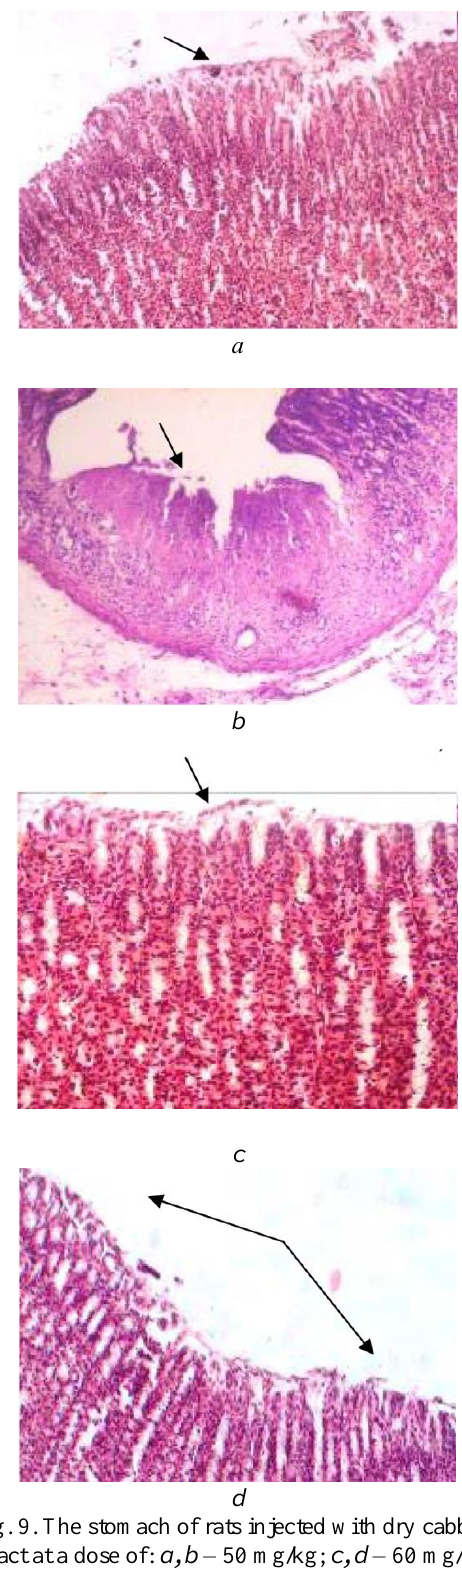
Fig. 9. The stomach of rats injected with dry cabbage extract at a dose of: a, b – 50 mg/kg; c, d – 60 mg/kg on the background of an alcohol-prednisolone mixture. Surface erosion of various stages of formation (a, b, d), ulcerative defect (c) of the prepyloric part. Haematoxy- lin-eosin. ×100,